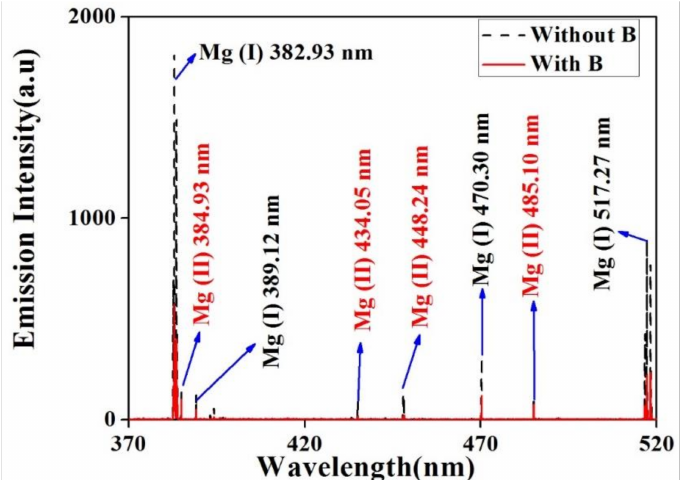
Figure 2. The emission spectra of selected Mg lines under 5 Torr pressure of Ar gas at 2 GW/cm 2 irradiance with and without TMF in the spectral range from 370 nm to 520